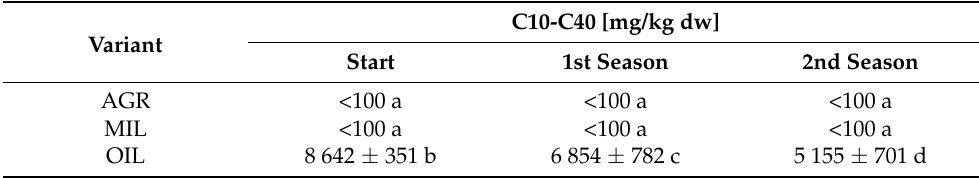
Table 2. Concentration of aliphatic hydrocarbons (C10-C40) in soil during experiment (mean ± SD, n = 4), the same letters behind values mark comparable results ( p < 0.05).